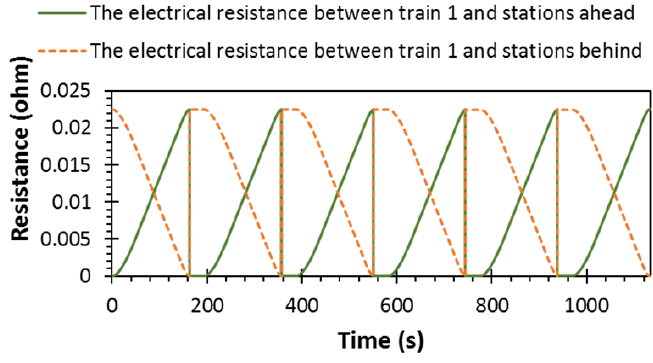
Figure 9. The electrical resistance between Train 1 and the passenger stations.